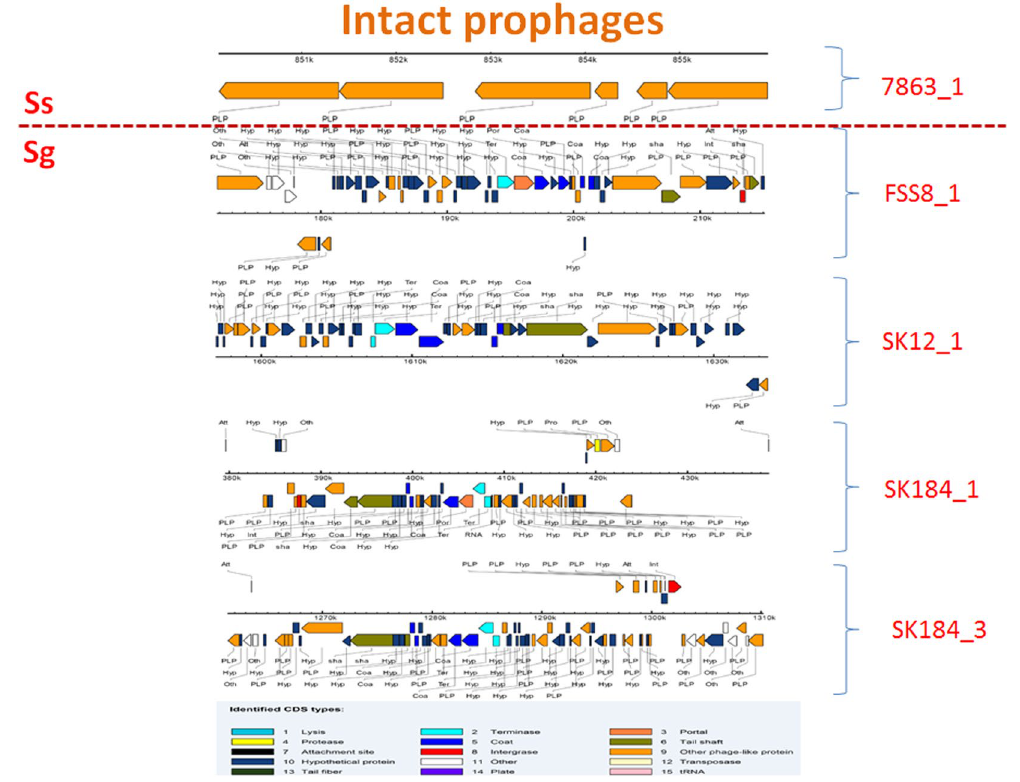
Figure 4. Intact prophages in Sg and Ss. 5 intact prophages were detected, of which four were present in Sg (FSS8_1, SK12_1, SK184_1 and SK184_3) and only one was found in Ss